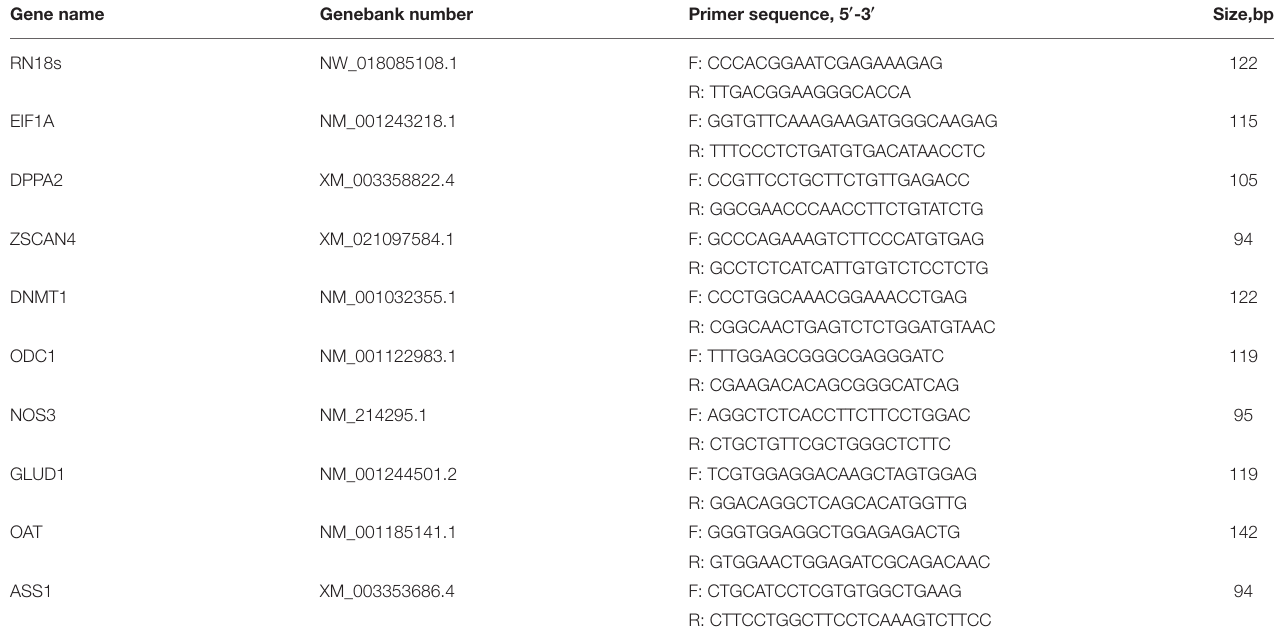
TABLE 2 | Primers list for